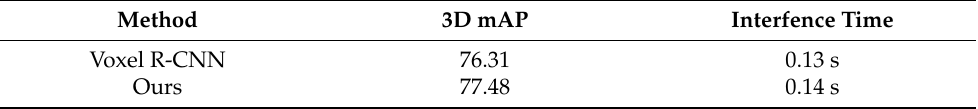
Table 5. Inference time comparison between Voxel R-CNN and our proposed method in the KITTI validation